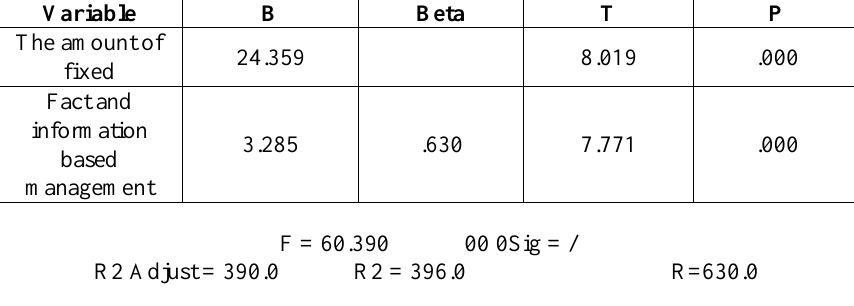
Table 4. Results of regression analysis for the third